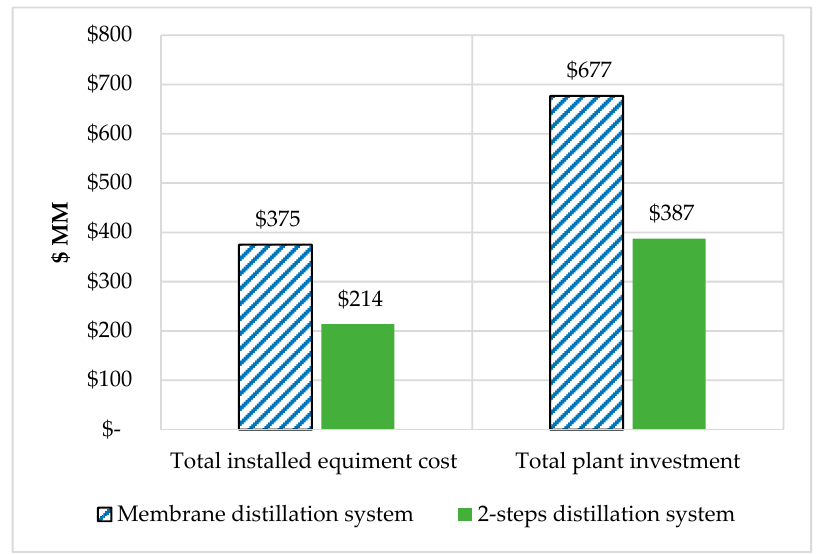
Figure 5. Comparison of capital investment of FW fermentation with membrane distillation and two-step distillation system for the separation process.